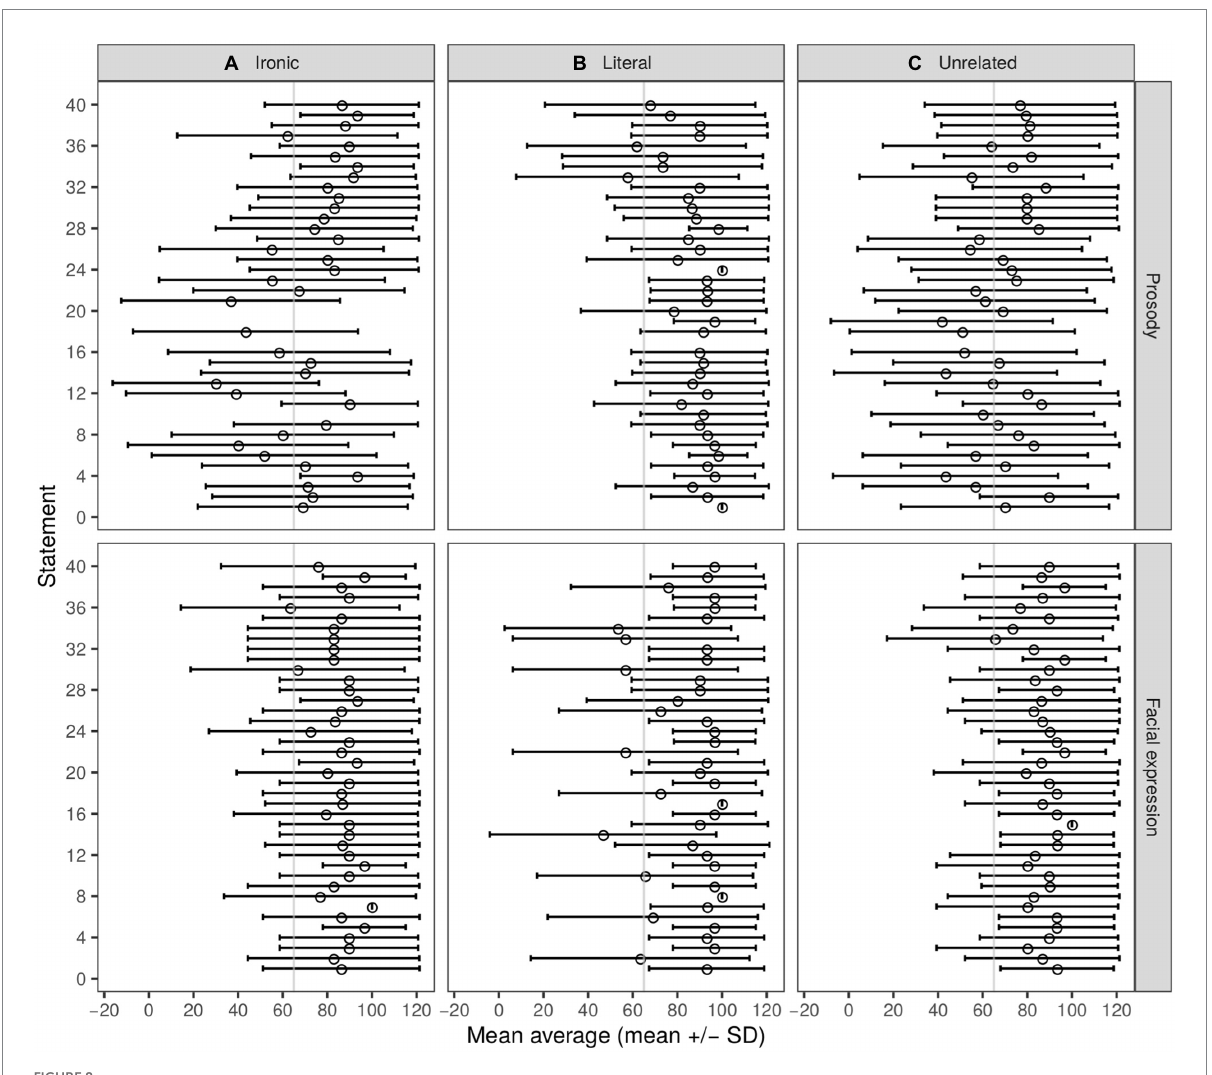
FIGURE 8 Classification accuracy for each statement for Experiment 2 that explored the effect of Prosody (upper panels) and Facial expression (lower panels) on the identification of irony. Classification accuracy represents the percentage of participants that classified each item accurately (mean + sd), according to its category (A) Ironic, (B) Literal, (C) Unrelated. The vertical gray line indicates the 65% classification accuracy, which was the minimum for